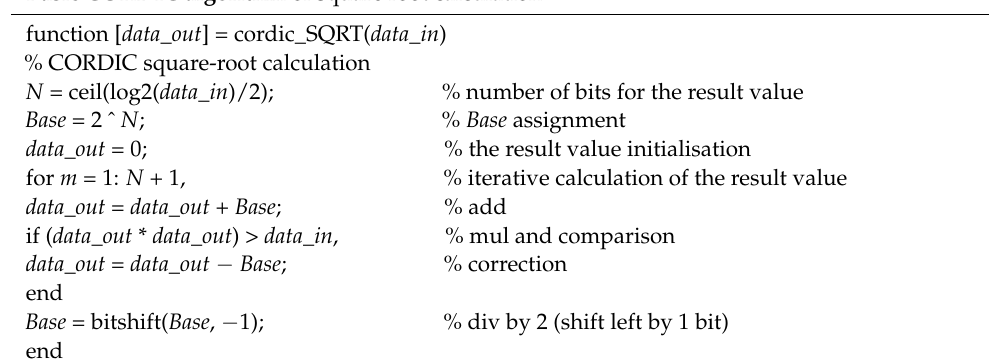
Basic CORDIC algorithm of square root